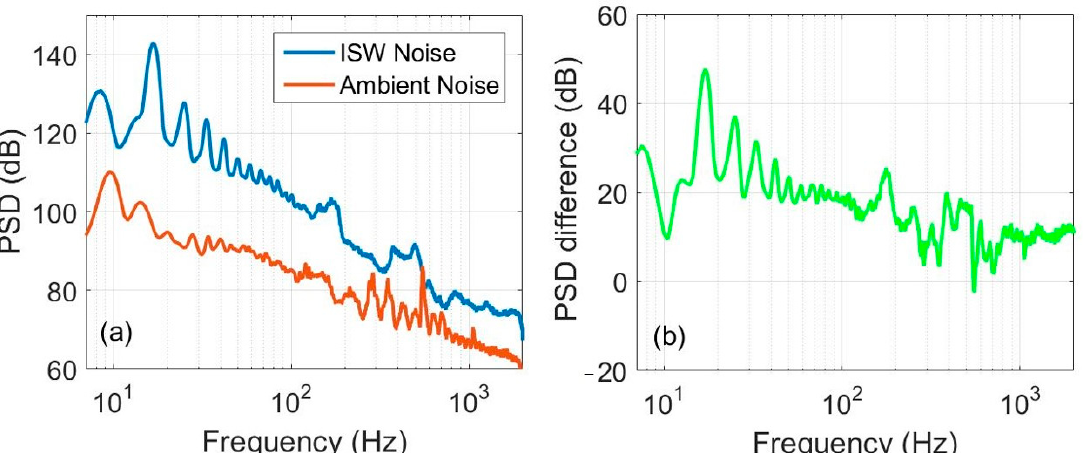
Figure 4. Power spectrum comparison of ISW noise and ambient noise. ( a ) PSD comparison. ( b ) The differences of PSD between ISW noise and ambient noise. ISW noise is from the 2 min data received by hydrophone C058 at depth of 700 m between 6:00 to 6:02 UTC+8 on 21 September 2016, and the ambient noise is from data three hours later (from 9:00 to 9:02 UTC+8).